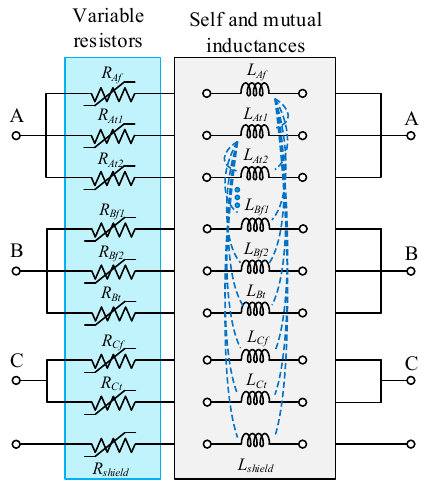
Figure 6. Cable modeling in PSCAD /